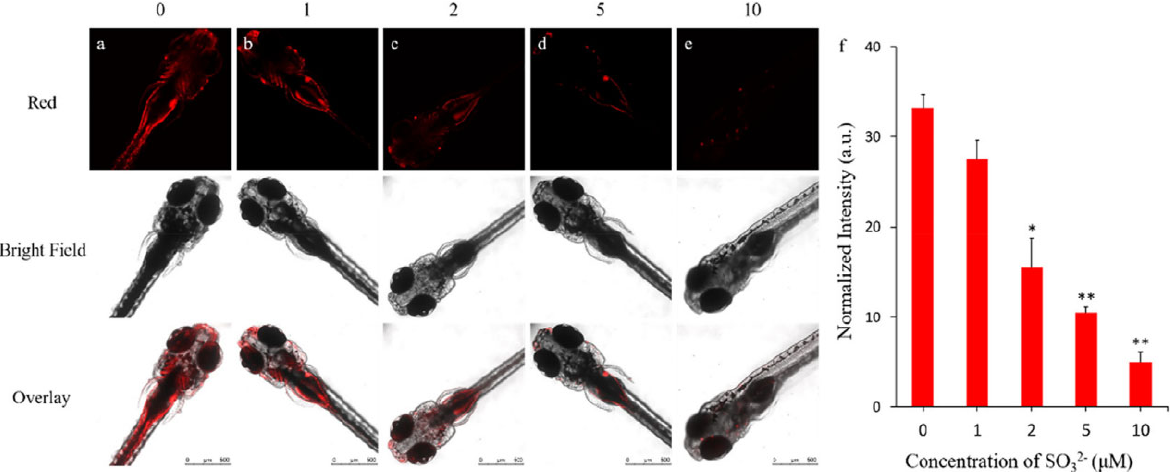
Figure 4. Imaging of SO 32 − in zebrafish by probe 47 . The zebrafish were stained with ( a ) 2 μ M probe 47 for 30 min; ( b ) 1 μ M SO 32 − for 30 min, 2 μ M probe 47 for 30 min; ( c ) 2 μ M SO 32 − for 30 min, 2 μ M probe 47 for 30 min; ( d ) 5 μ M SO 32 − for 30 min, 2 μ M probe 47 for 30 min; ( e ) 10 μ M SO 32 − for 30 min, 2 μ M probe 47 for 30 min. ( f ) Different normalized intensities toward different concentrations of SO 32 − , respectively. Red channel: λ ex = 552 nm λ em = 600–660 nm. Values are the means ± SD for each group of three experiments; * p < 0.05, ** p < 0.01. Reproduced with permission from Ref. [80]. Copyright (2020) Elsevier.